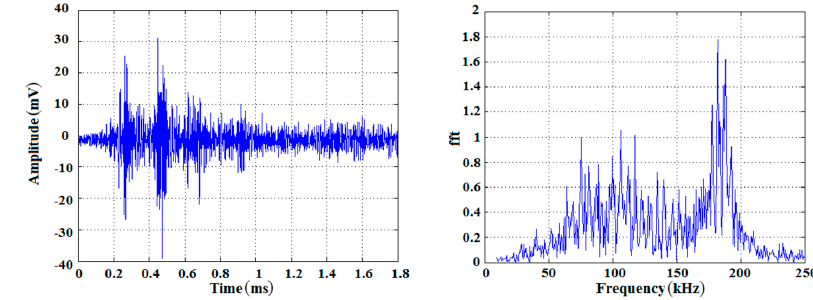
Figure 8. Signals from Hsu-Nielsen source at 1 m distance from AE sensor.